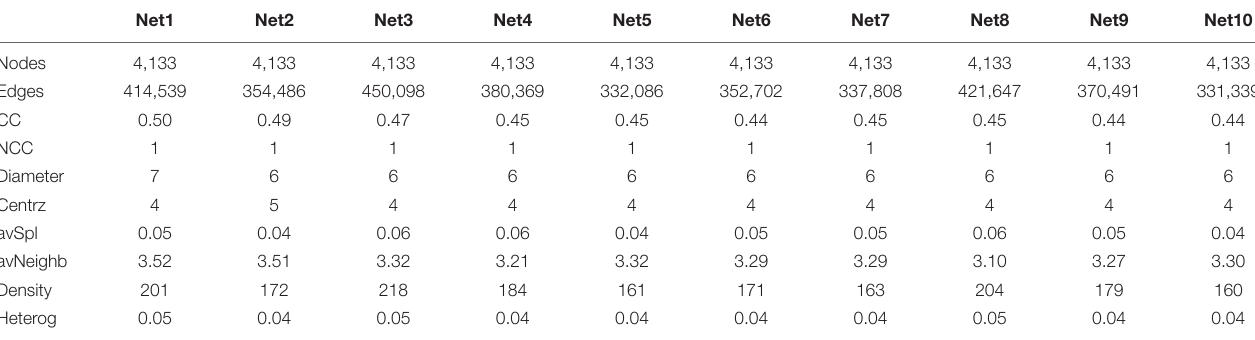
TABLE 1 | Topological parameters of co-expression